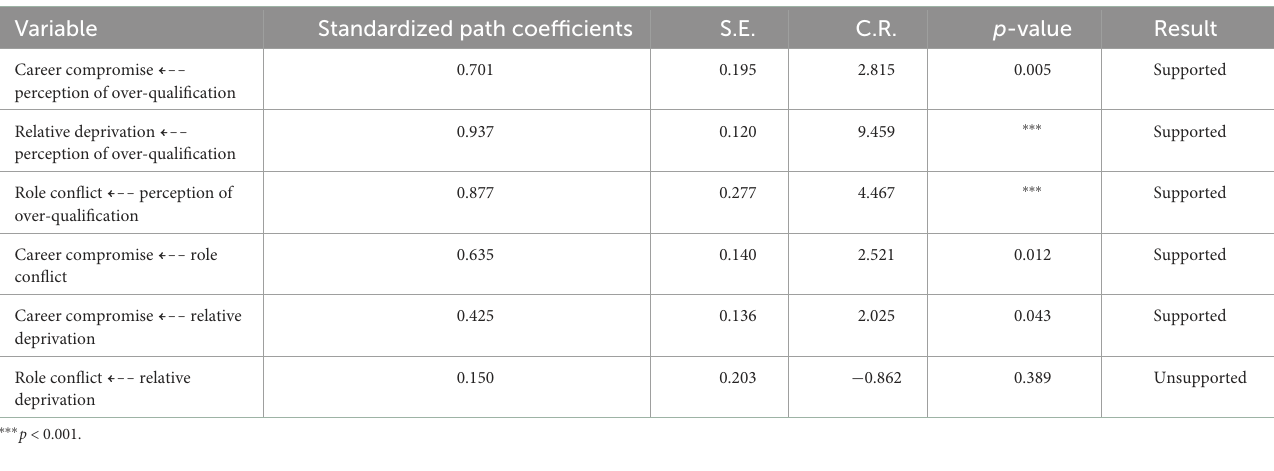
TABLE 5 Model parameter estimation.